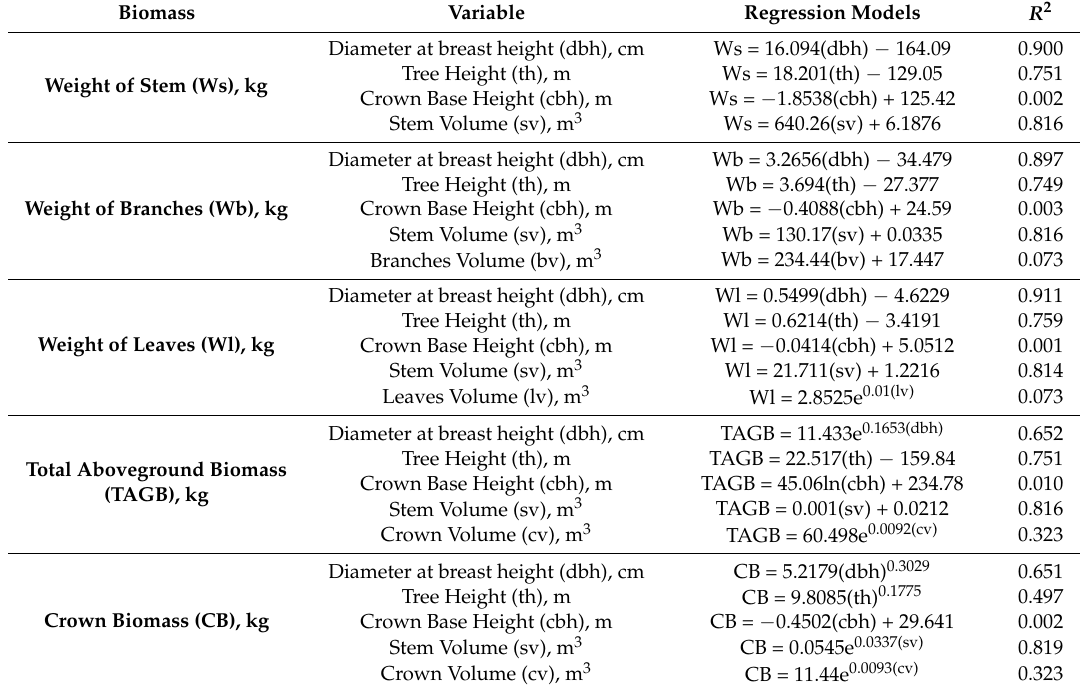
Table A3. Allometric equation generated for Resak with tree variables obtained from TLS. Biomass